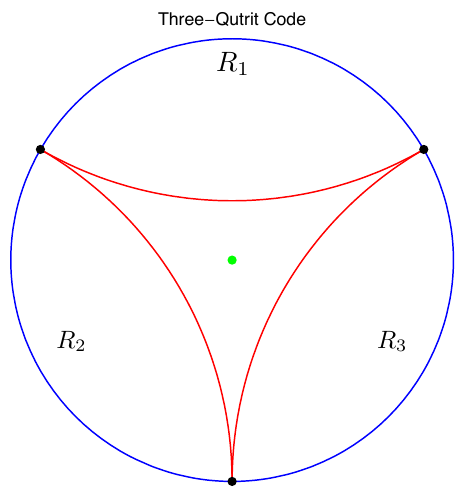
Figure 7 . The Three-Qutrit Code